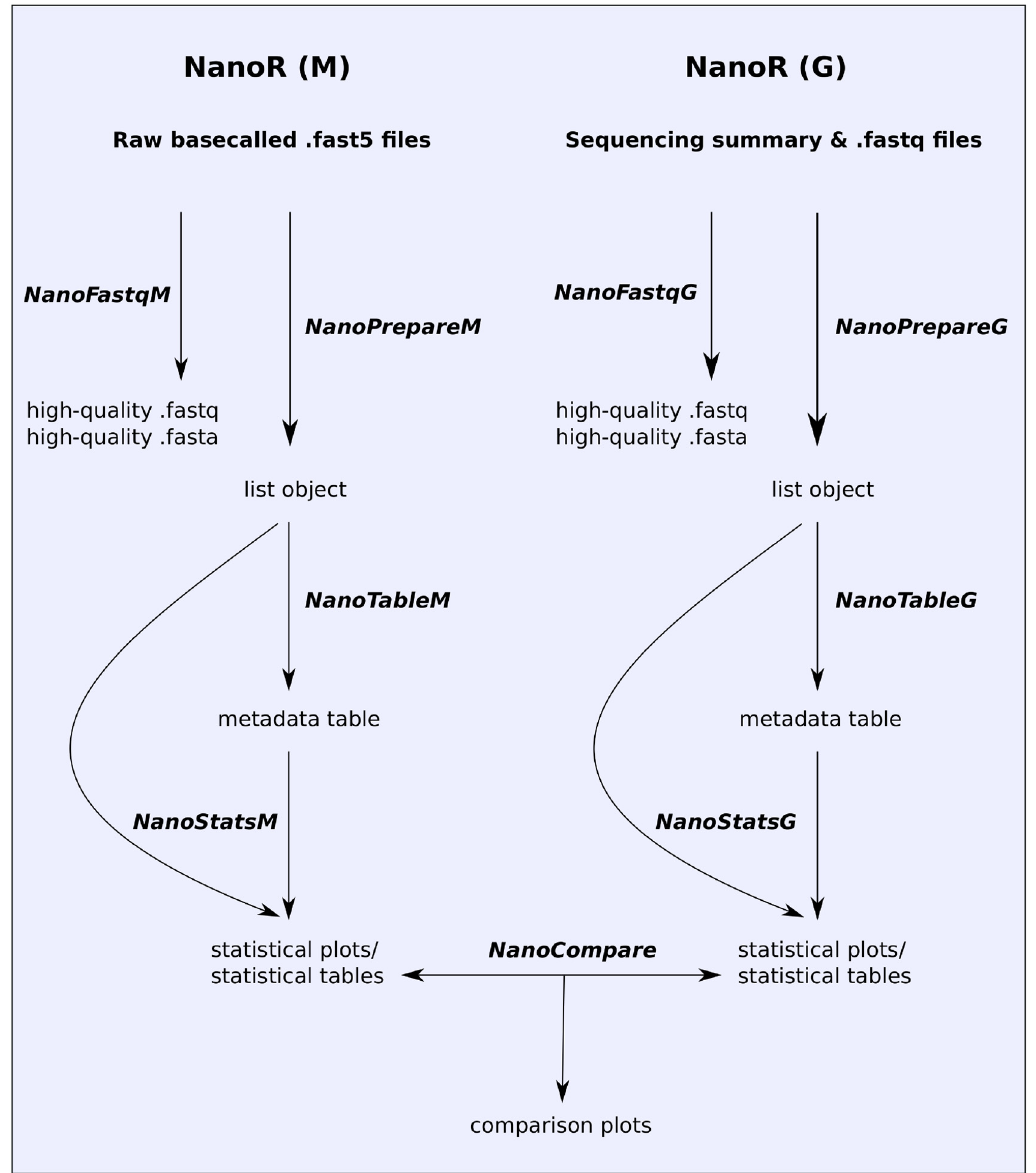
Fig 1. NanoR workflow. NanoR can work with both basecalled . fast5 files and sequencing summary/. fastq files. Users have to rely on NanoFastqM() to direclty extract . fastq sequences from basecalled . fast5 files and on NanoFastqG() to filter . fastq files. NanoPrepare() functions, as well as NanoTable() and NanoStats() can be used one after another to generate a complete overview for the sequencing run, starting from basecalled . fast5 files (“M” version) or from sequencing summary and . fastq files (“G” version). NanoCompare() , at last, allows one-command comparison of MinION/GridION X5 analyzed sequencing